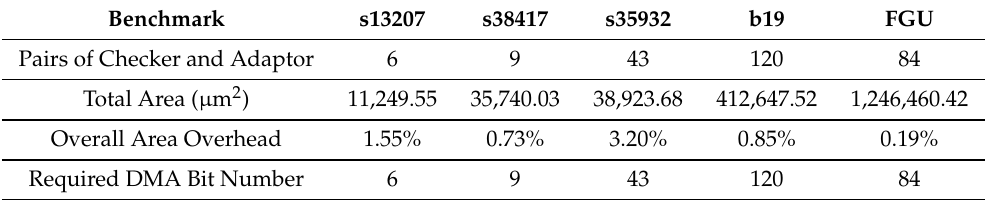
Table 2. The area overhead of the proposed system on different